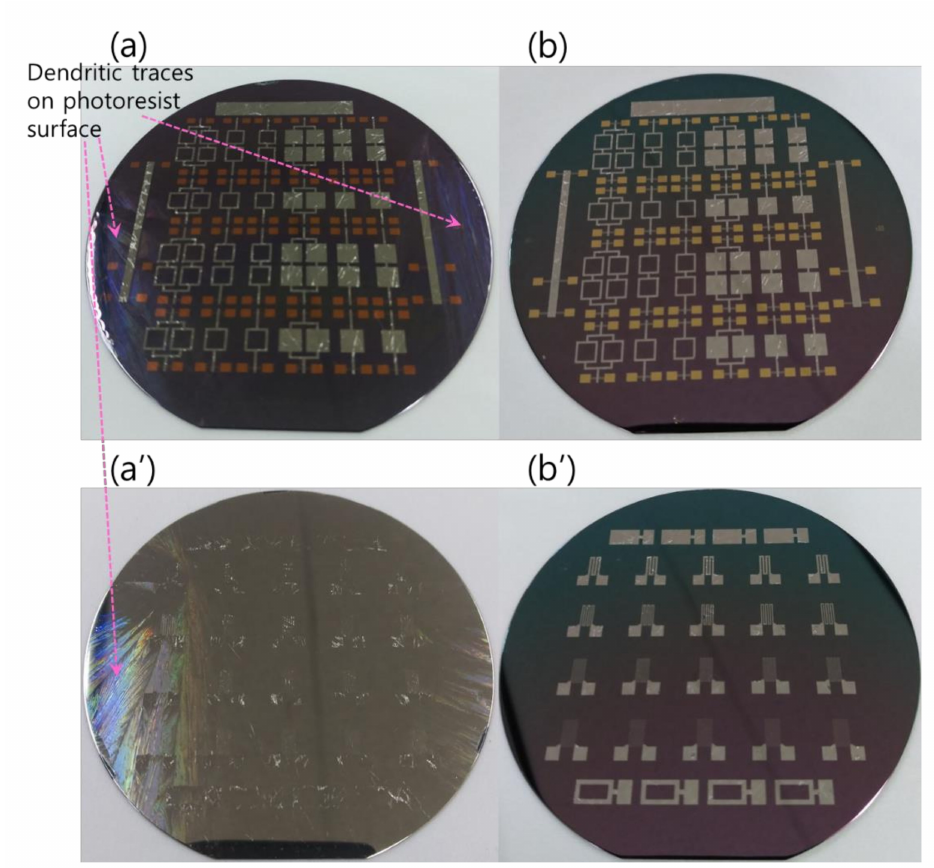
Figure 13. Dendritic traces on a photoresist film surface after spontaneous self-ignition. ( a , a’ ) Wafer surfaces before photoresist lift-off; ( b , b’ ) Wafer surfaces after photoresist